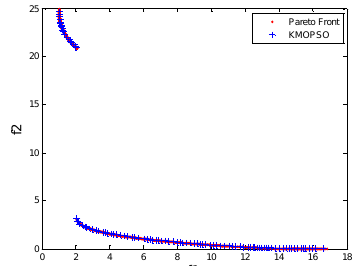
Fig. 7. Pareto fronts produced by KMOPSO for POL.